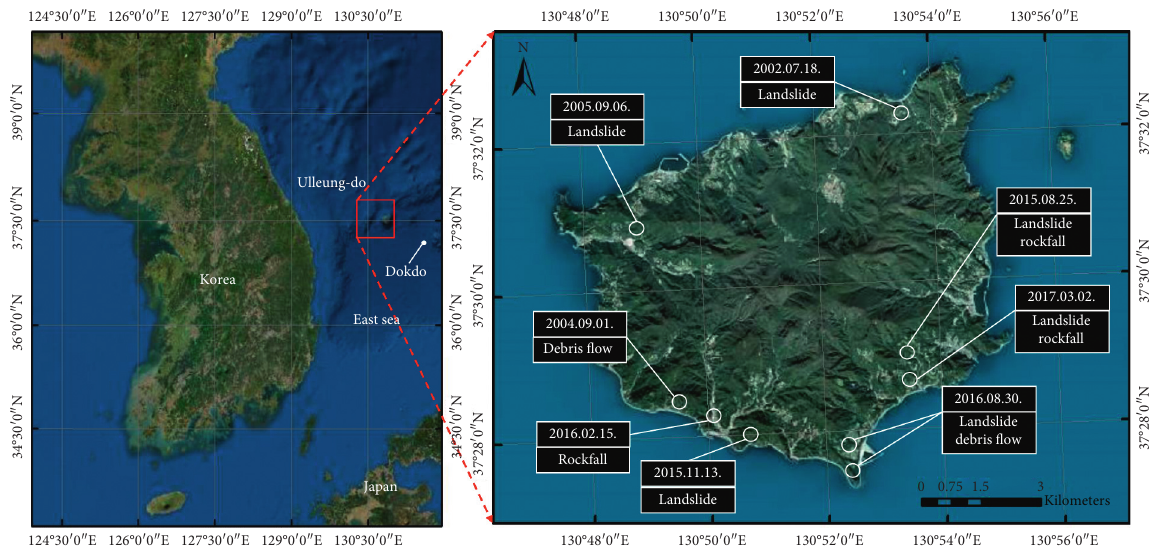
Figure 1: Major mountainous disasters in Ulleung-do Island for 15 years from 2002 to 2016. Table 1: Major steep slope disasters in Ulleung-do Island. Date Cause Details Localized heavy Landslides in Cheonbu-ri, Buk-myeon, and Uleung-gun rainfall Typhoon “Nabi” Landslides in the upper part of Namseo Tunnel, Seomyeon, and Uleung-gun Aug. 25, Typhoon “Goni” Rockfalls and landslides in the upper part of Guam Tunnel, Seomyeon, and Uleung-gun